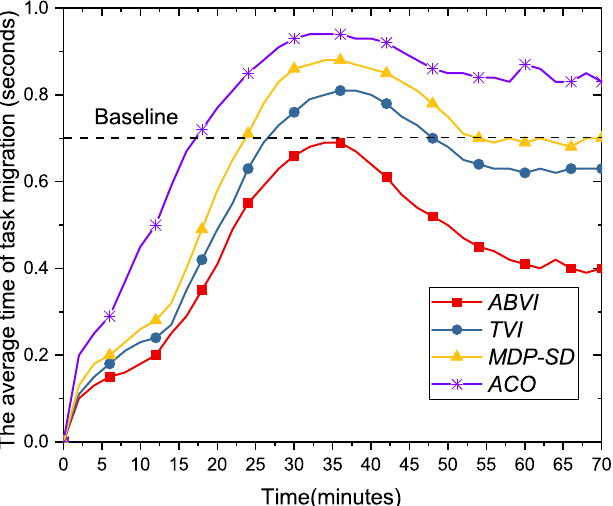
Figure 5. The average task migration time versus time.